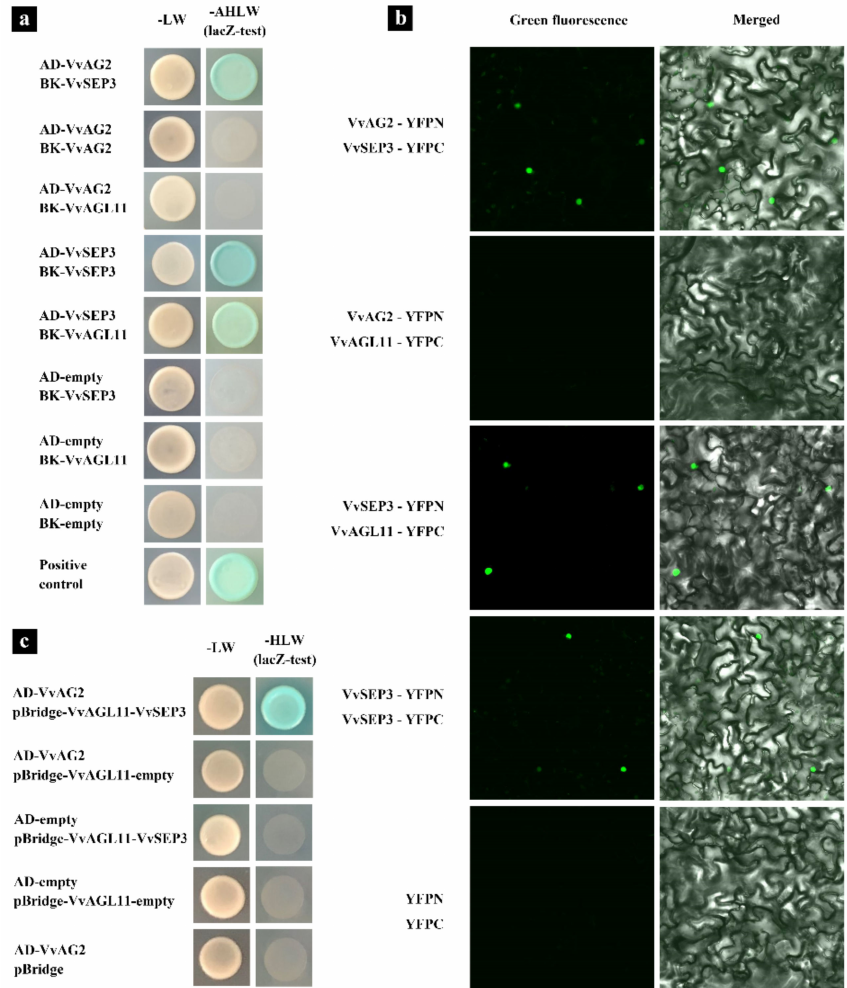
Figure 8. The interaction between MADS-box family proteins VvAG2, VvSEP3 and VvAGL11. ( a ) Y2H assay showed that both VvAG2 and VvAGL11 interacted with VvSEP3, and VvSEP3 could interact with itself. PGBKT7-53 (p53) and PGADT7-T (SV40 large T-antigen) were used as a positive control. ( b ) BiFC experimental analysis verified the interaction of VvAG2, VvSEP3 and VvAGL11. ( c ) Y3H assay showed that VvAG2 and VvAGL11 could interact when VvSEP3 was